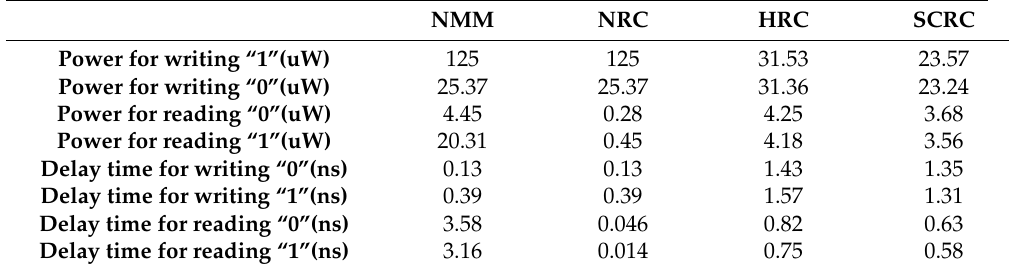
Figure 10. ( a ) Output waveform diagram of NMM for reading logic “0”; ( b ) output waveform diagram of NRC for reading logic “0”; ( c ) output waveform diagram of HRC for reading logic “0”; and ( d ) voltage waveform diagram at V 2 of SCRC for reading logic “0”. Table 3. Results of continuous reading of logic “0”. Table 4. Comparison of power consumption and delay of read–write operation in different circuits.